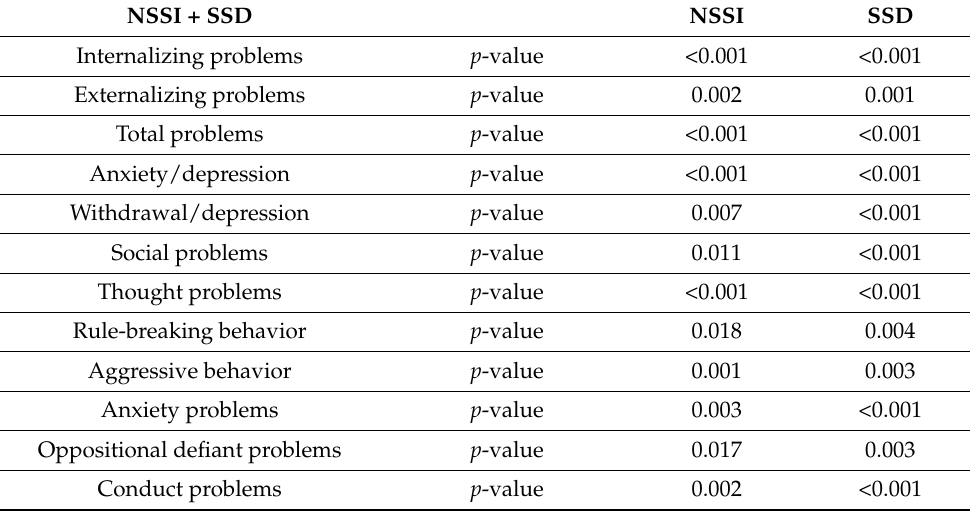
Table 2. Games Howell post-hoc test with statistically significant differences between the NSSI + SSD group and the other two groups on the Youth Self-Report 11–18 (YSR)